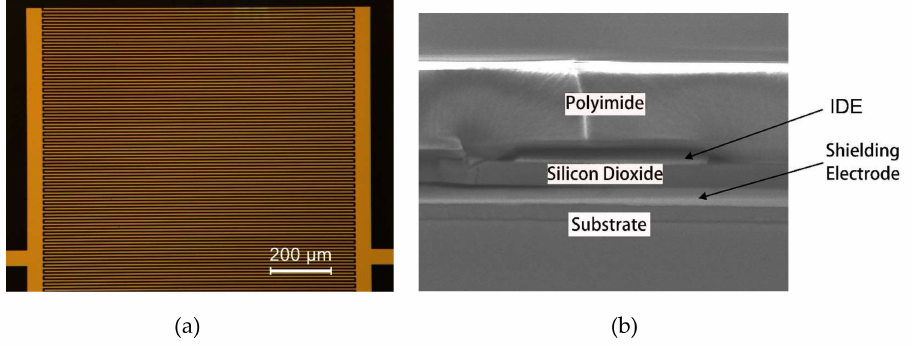
Figure 5. SIDE sensor picture under microscopy, and its cross-section image under